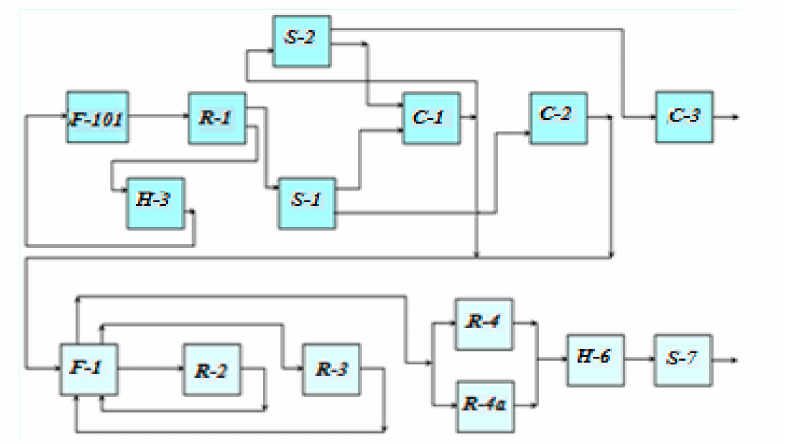
Figure 3. Scheme of combining models of the main units of hydrotreating and reforming units of the LG-35-11/300-95 catalytic reforming unit of the Atyrau Refinery into a package of